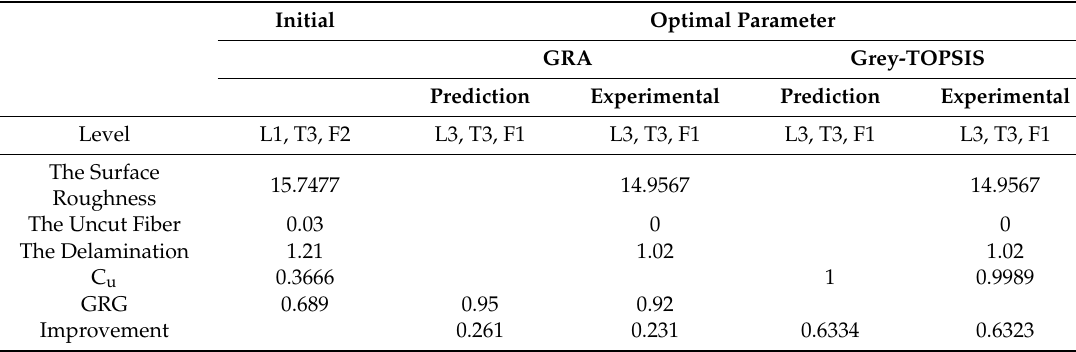
Table 10. Initial, predicted, and compared evaluation